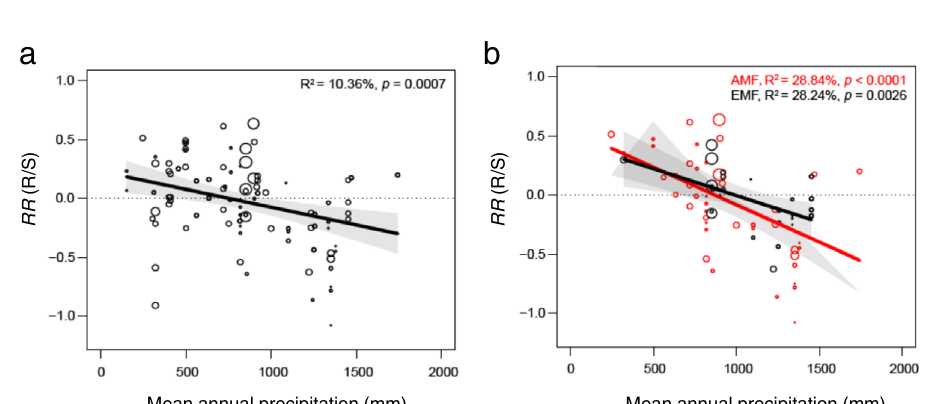
Fig. 3 | Importance ofvarious predictor variables, and variance explanationof root:shoot ratioin responsetowarming. Model-averaged importance of various predictor variables for warming effects on root:shoot ratio [i.e., RR (R/S)]. b The proportion of total variance of RR (R/S) is explained by biomes, plant community composition, and mycorrhizal fungi type (MFT). The variables with an importance value >0.8 were considered as essential predictors. The importance value of a predictor is based on the sum of Akaike weights derived from the model selection using corrected Akaike ’ s information criteria. MFT mycorrhizal fungi type, PFT plant functional type, MAP mean annual precipitation, MAT mean annual